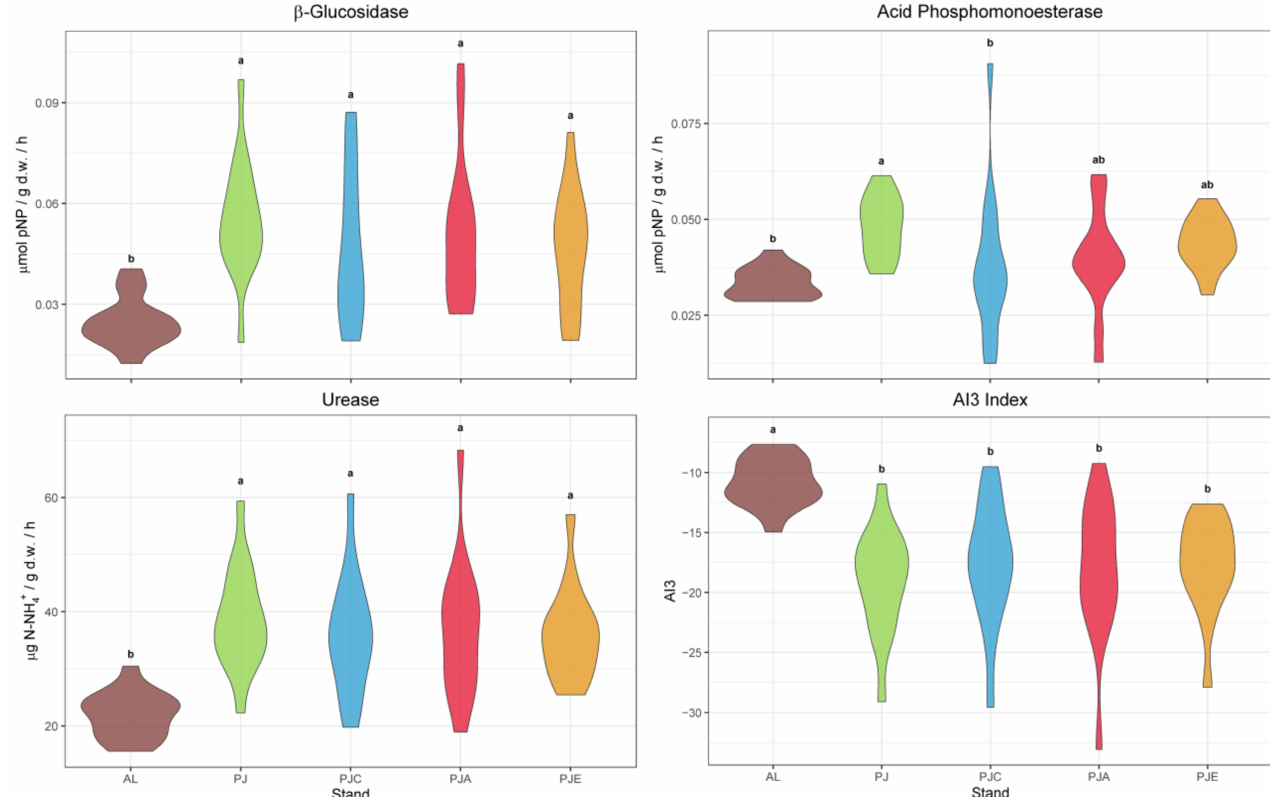
Figure 3. Violin plot of the enzymatic activities in the tree stands and agricultural land plots (see Table 1 for site labels). β -glucosidase; acid phosphomonoesterase; urease; AI3 index. Different letters indicate significant differences ( p ≤ 0.05, Tukey’s post-hoc test following one-way